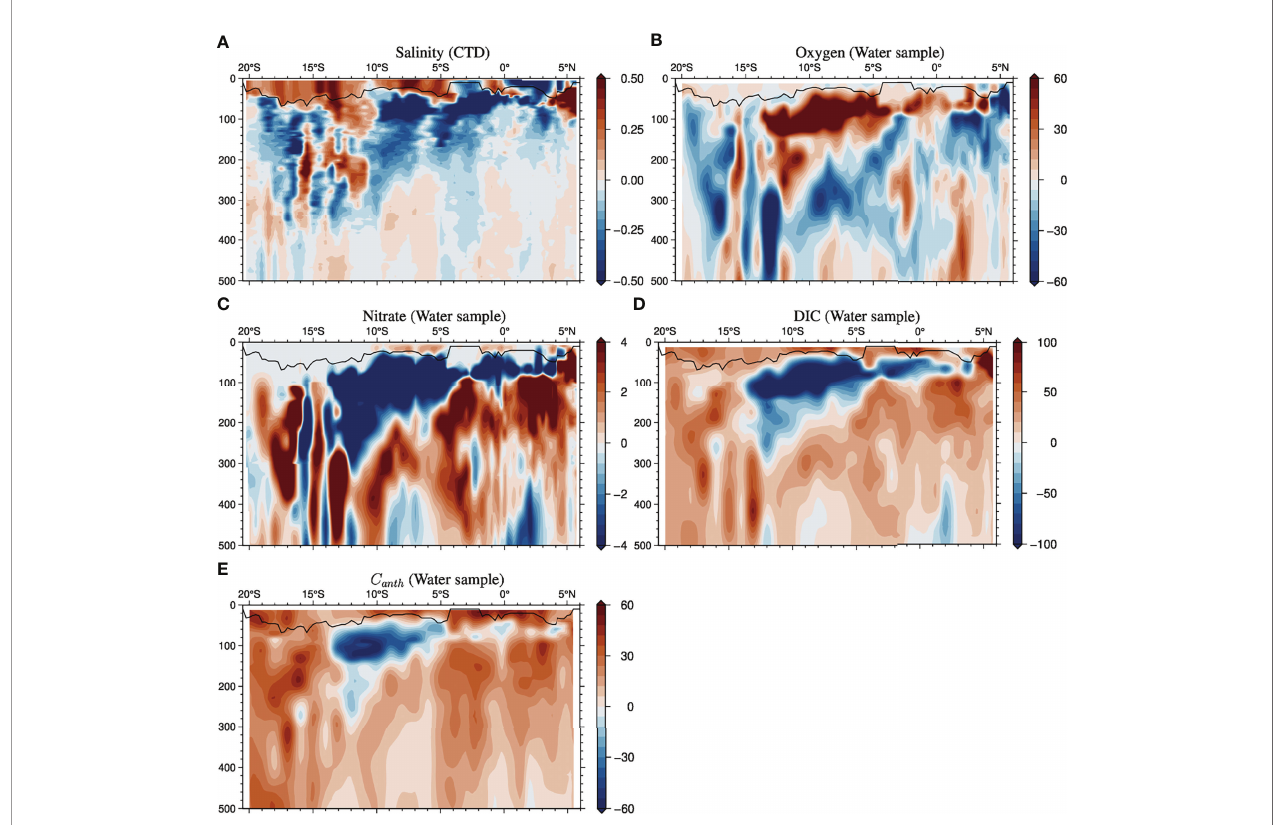
FIGURE 13 | Same as Figure 2 but for the changes from March 1995 to December